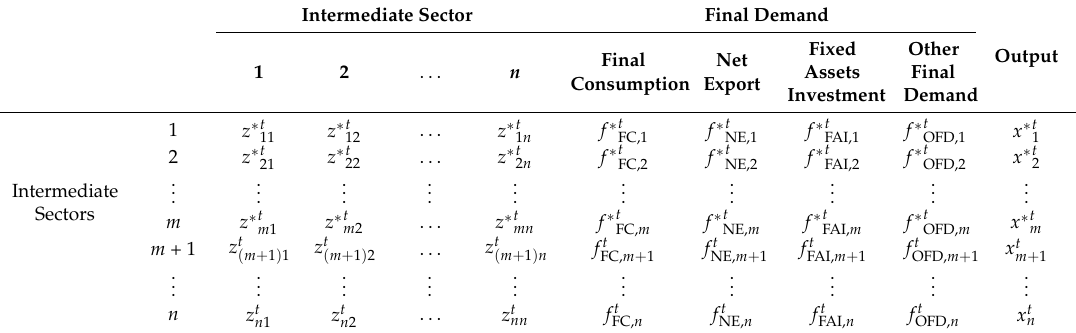
Other Fixed Output Final Net Final Assets Consumption Export Demand Investment